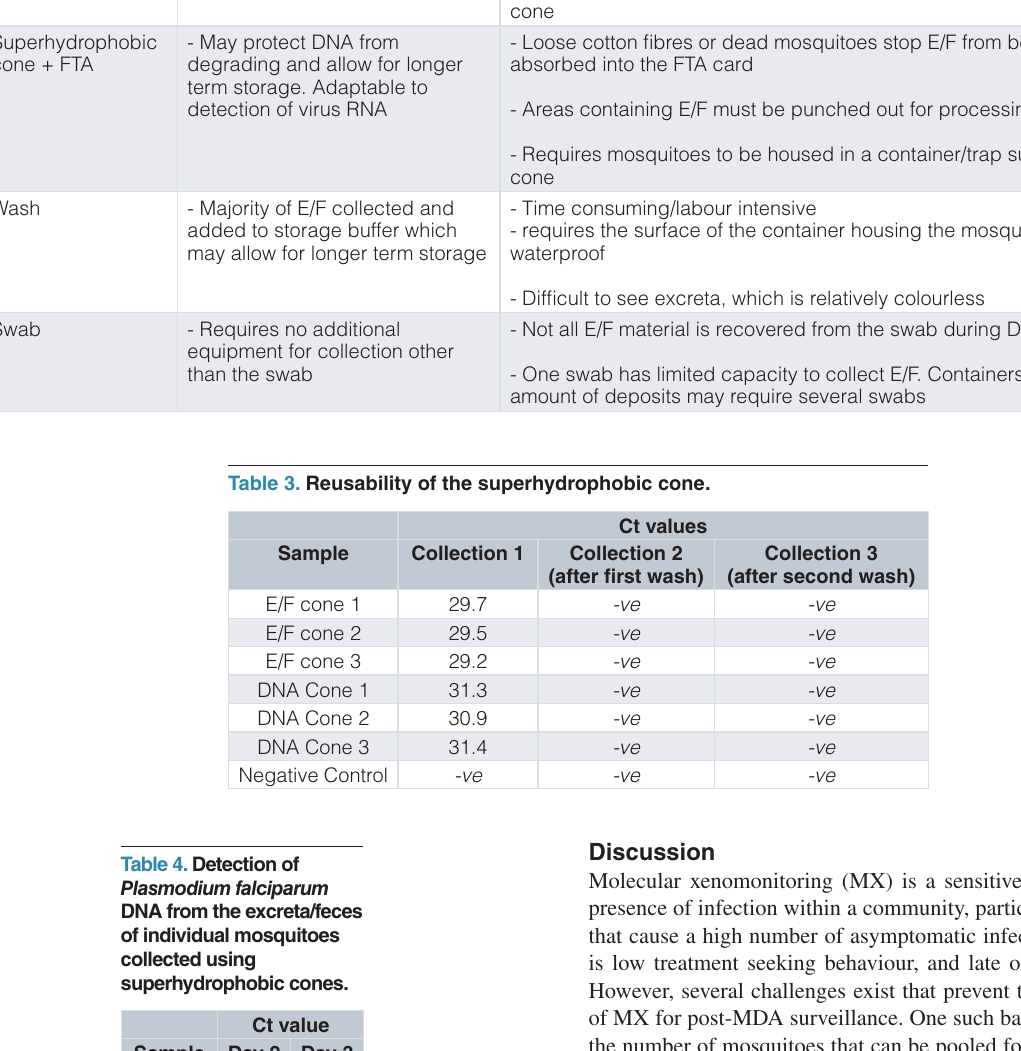
Superhydrophobic cone +